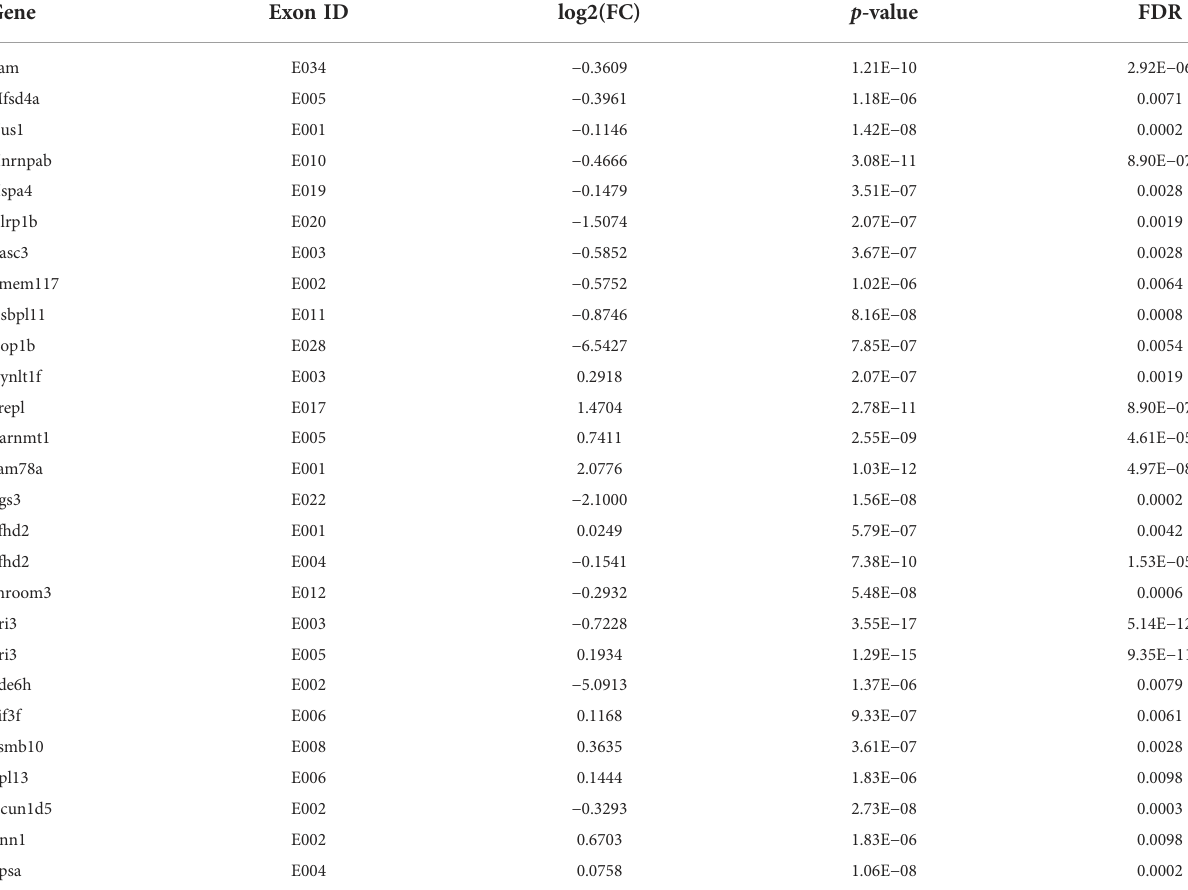
TABLE 7 DEU Analysis at exon levels in K. pintolopesii treated mice, DEXSeq was used to analysis DEU and performed FDR as the